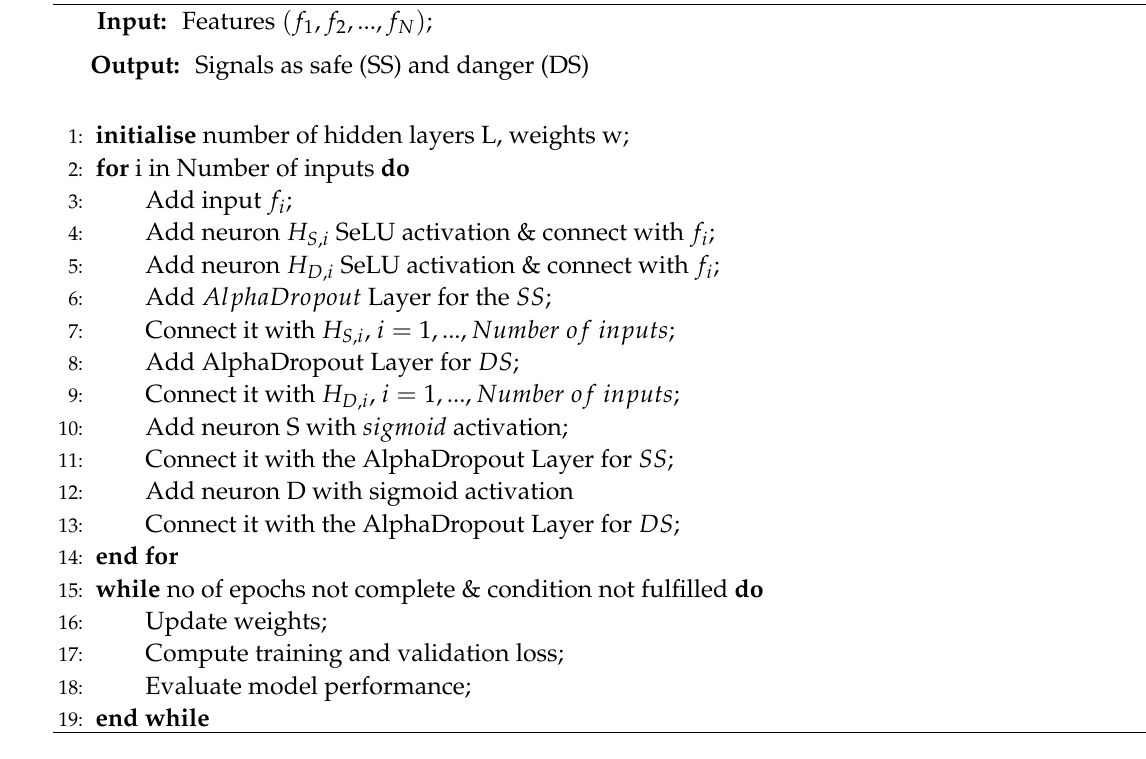
Algorithm 1 SSN for Signal